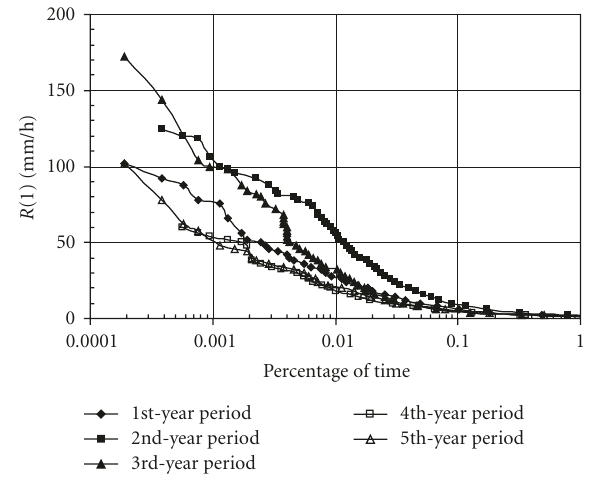
Figure 1: CDs of average 1-minute rain intensities for individual 1-year periods.